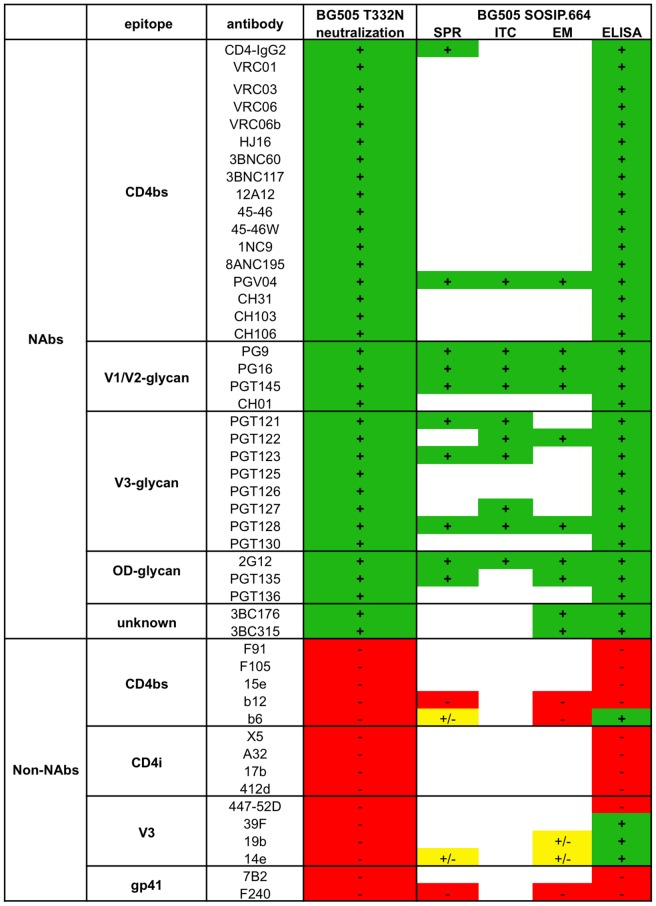
BG505 SOSIP.664 antigenicity summary for bNAbs and non-NAbs.The following scoring was used for neutralization: +: IC50<30,000 ng/ml; −: IC50>30,000 ng/ml. See Table 1 for details. The following scoring was used for SPR analyses: +: >70 RU; +/−: >30 RU, <70 RU; −: <30 RU, based on plateau estimates of 1,000 nM for IgG and 500 nM for Fab. See Fig. 7 for details. In SPR CD4 binding results were obtained with sCD4 not CD4-IgG2. b6 binding was absent with b6 Fab (−) and low with b6 IgG (+/−). The following scoring was used for ITC experiments: +: N>1.2 (except for PG9, PG16 and PGT145 where N>0.4) and Kd<300 nM; −: N<1.2 and Kd>300 nM, where N is the stoichiometry of binding. See Table 1 and Fig. 8 for details. . The following scoring was used for EM analyses: +: N = 3 (except for PG9, PG16 and PGT145 where N = 1) for >50% of the trimers; +/−: N = 3 for <50% of the trimers; −: N = 1,2 or 3 for <10% of the trimers, where N is the number of Fabs bound per trimer. See Table 2, Fig. 9 and Fig. 10 for details. Note that ITC data with PG16 and PGT127 were obtained using BG505 SOSIP.664 trimers produced in GnTI-defective HEK293S cells. No ITC experiments were performed with non-NAbs. The following scoring was used for ELISA experiments: +: EC50<10,000 ng/ml; EC50>10,000 ng/ml. See Figs. 3–5 for details.